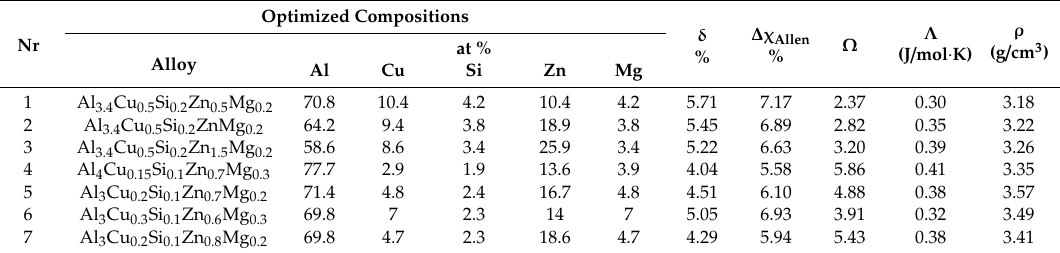
Table 2. Multiobjective optimization results for Al-Cu-Si-Zn-Mg